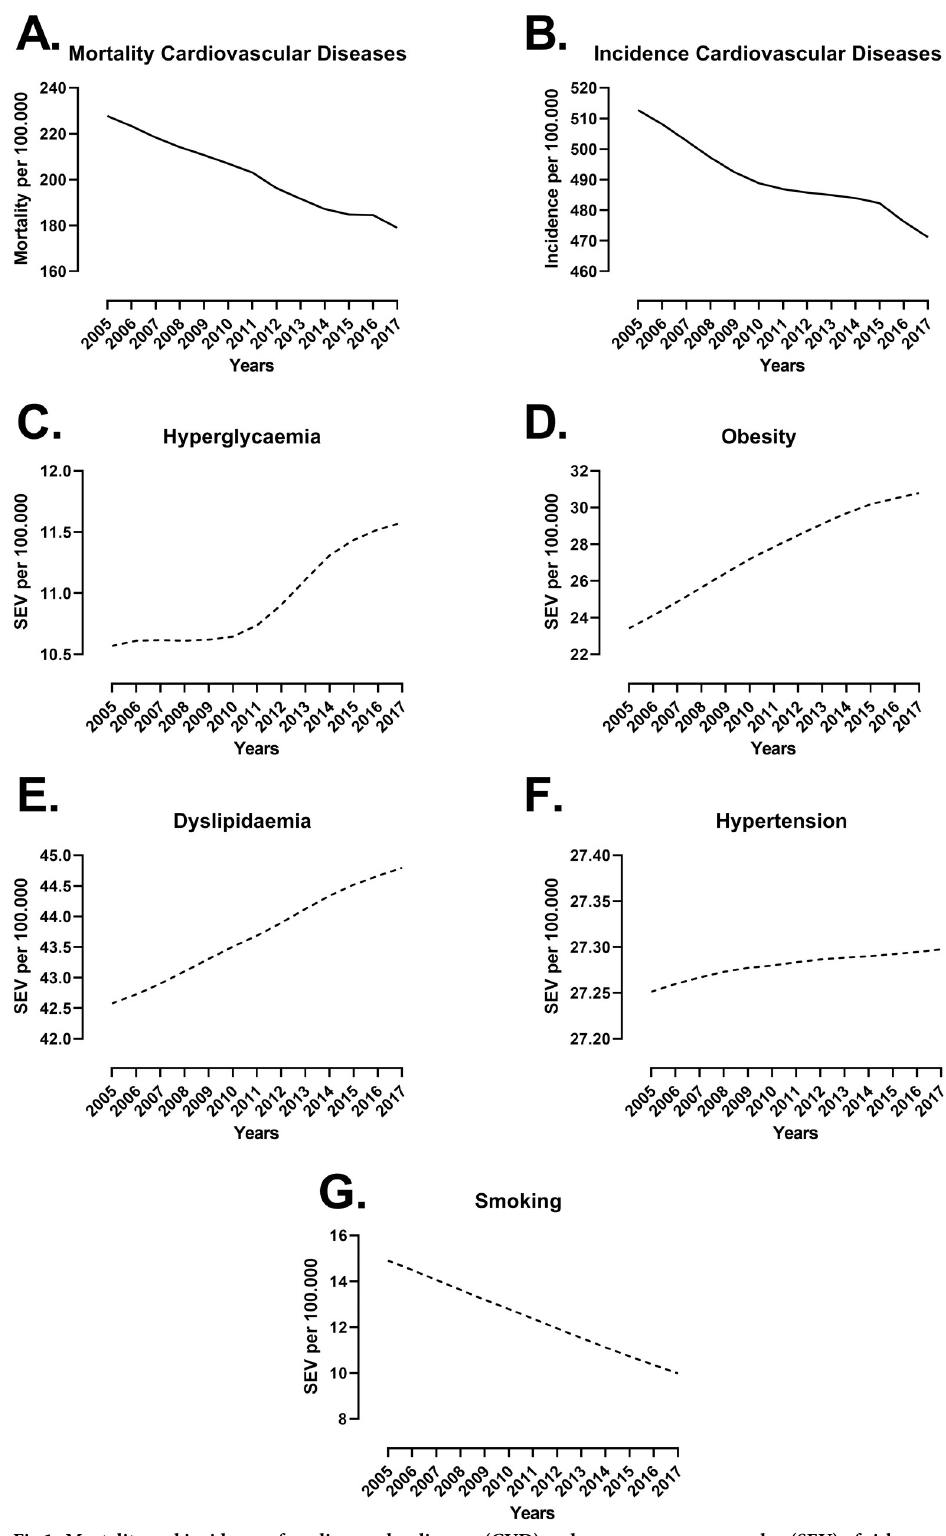
Fig 1. Mortality and incidence of cardiovascular diseases (CVD) and summary exposure value (SEV) of risk factors in Brazil between 2005 and 2017. Age-standardized national data for both sexes were obtained from